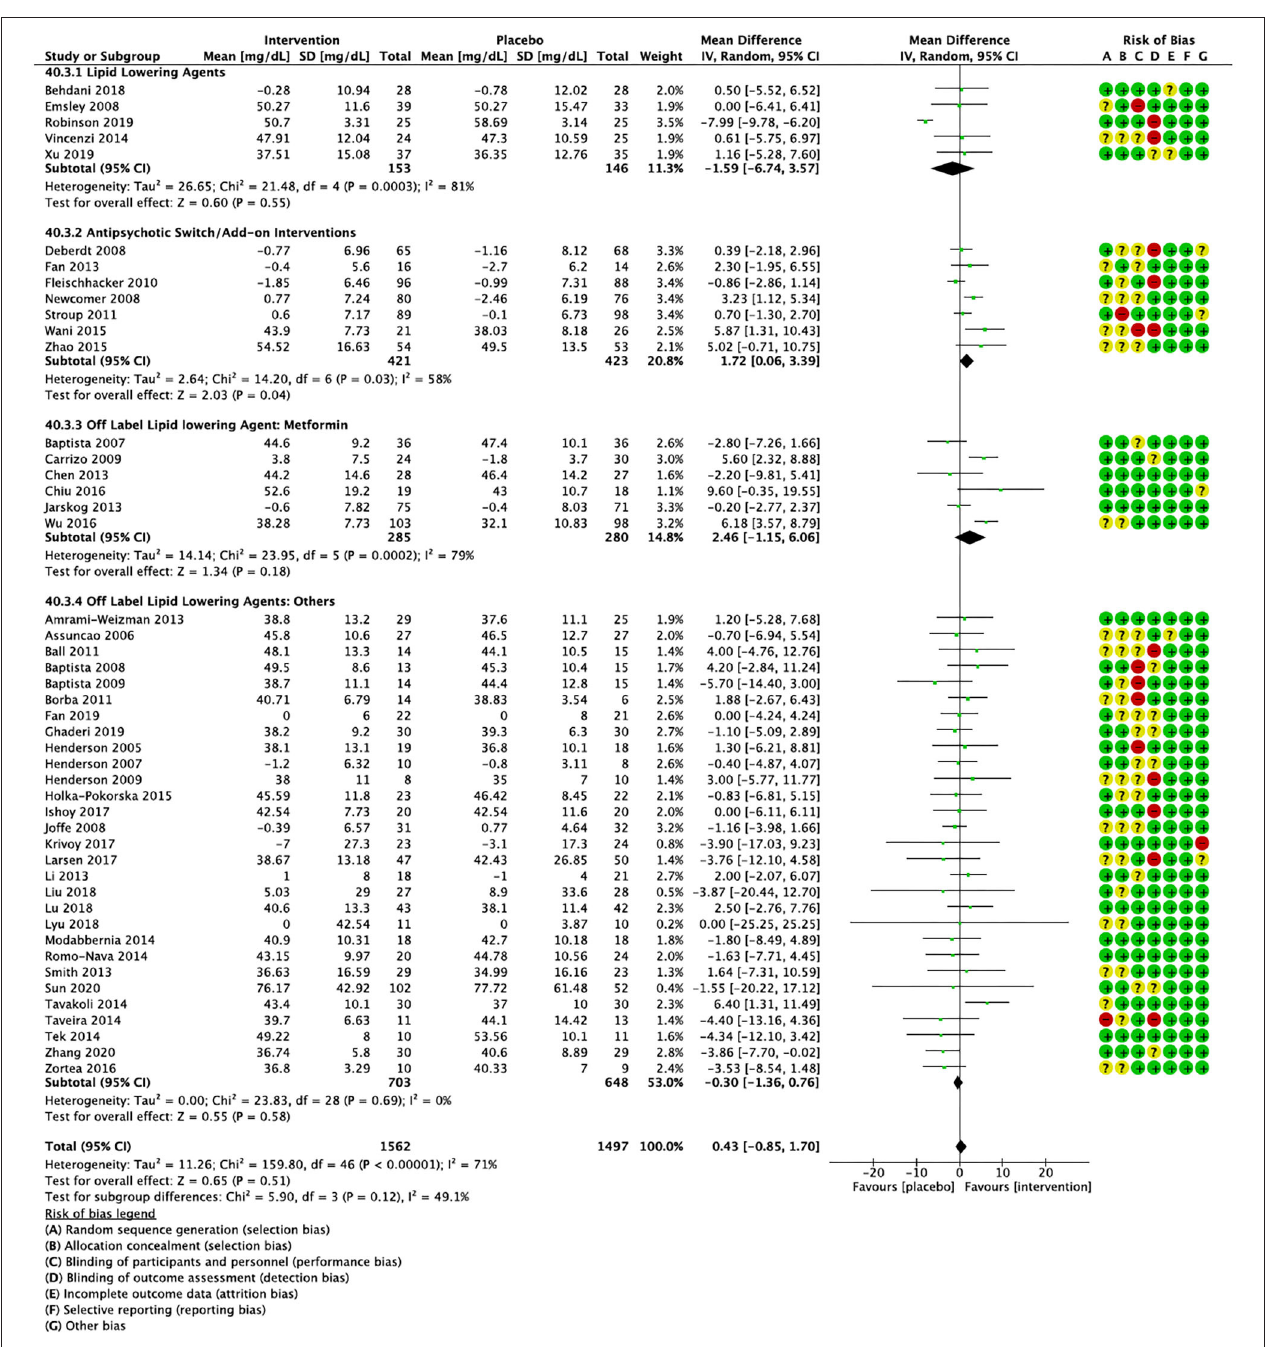
FIGURE 3 | Forest plot showing the pooled mean difference in changes in high-density lipoprotein cholesterol (mg/dL) for all interventions as compared to placebo along with subgroup analyses and Risk of Bias assessments.